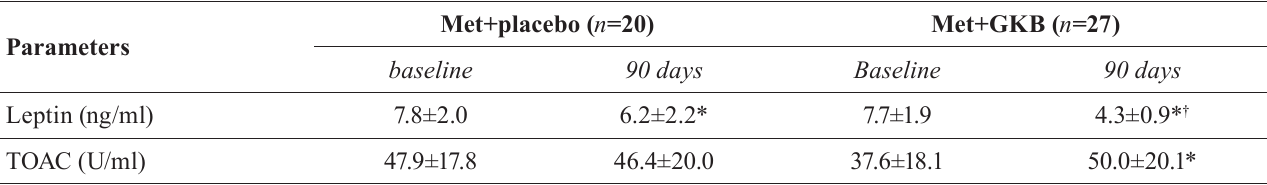
TABLE IV - Changes in the serum leptin level and total antioxidant capacity (TOAC) of T2DM patients maintained on metformin and treated with Ginkgo biloba extract Met+placebo ( n =20) Met+GKB ( n =27) Parameters baseline 90 days Baseline 90 days Leptin (ng/ml) 7.8±2.0 6.2±2.2* TOAC (U/ml) 47.9±17.8 46.4±20.0 37.6±18.1 50.0±20.1* Values are mean±SD; n : number of patients; * significantly different from baseline in each group (paired t -test, P <0.05); † significantly different from Met-placebo post-treatment (unpaired t -test, P <0.05); ANOVA: No significant differences between baseline values of all markers ( P >0.05); Met: metformin: GKB: 120 mg Ginkgo biloba